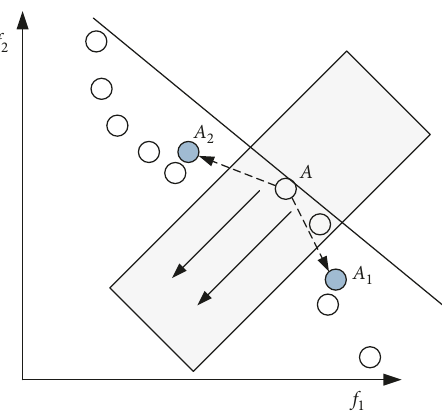
Figure 3: Illustration of motivation 3 : given a solution A , a child solution might be A or A . If weighted sum approach is used, it is 1 2 or A . However, A is a possible that A will be replaced by A 1 2 nondominated solution, while A and A are both dominated. If we 1 2 restrict the replacement in a certain scope, denoted by the gray area, A can be maintained in the population.